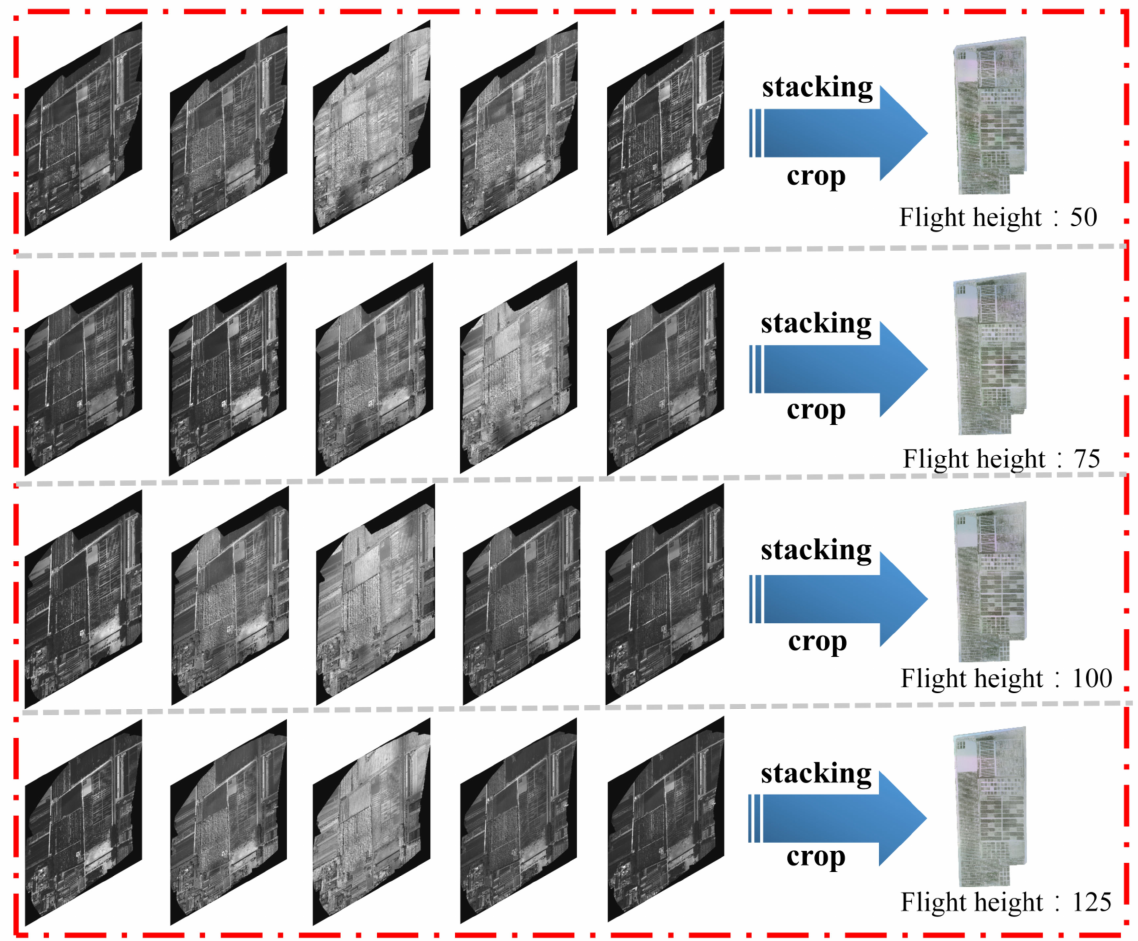
Figure 7. Remote Sensing Image Band stacking and